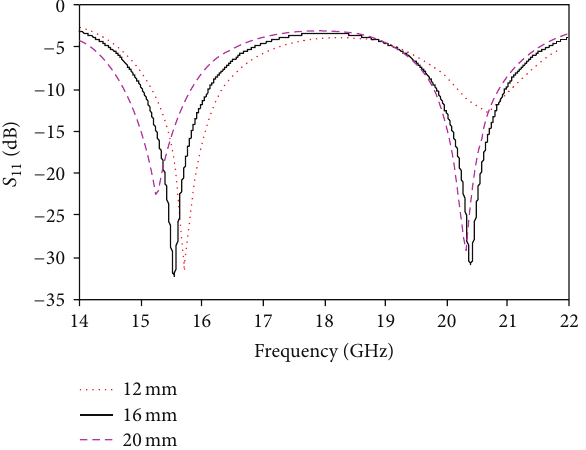
Figure 7: Simulated return loss for different values of 𝐿 3 .